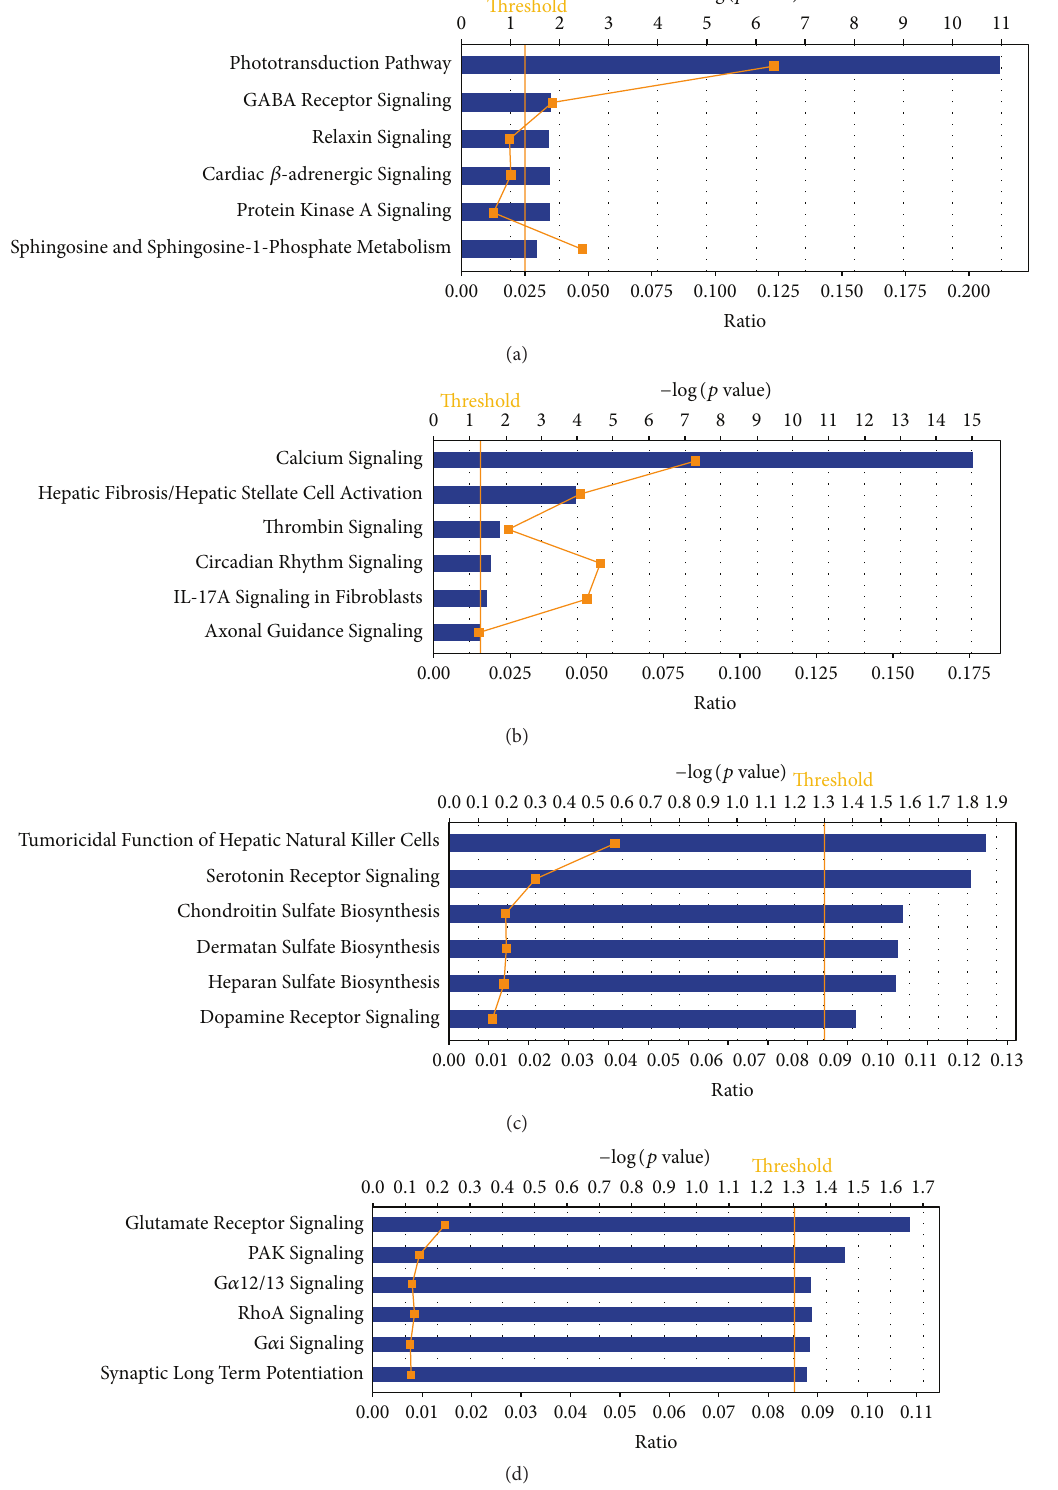
Figure 6: Top pathways identified by Ingenuity Pathway Analysis. (a) Top canonical pathways for DEX 1 week, 𝑡 -test, FC 1.5, 𝑝 < 0.05 . (b) Top canonical pathways for TAA 1 week, 𝑡 -test, FC 1.5, 𝑝 < 0.05 . (c) Top canonical pathways for DEX 30 days, 𝑡 -test, FC 1.5, 𝑝 < 0.05 . (d) Top canonical pathways for TAA 30 days, 𝑡 -test, FC 1.5, 𝑝 < 0.05